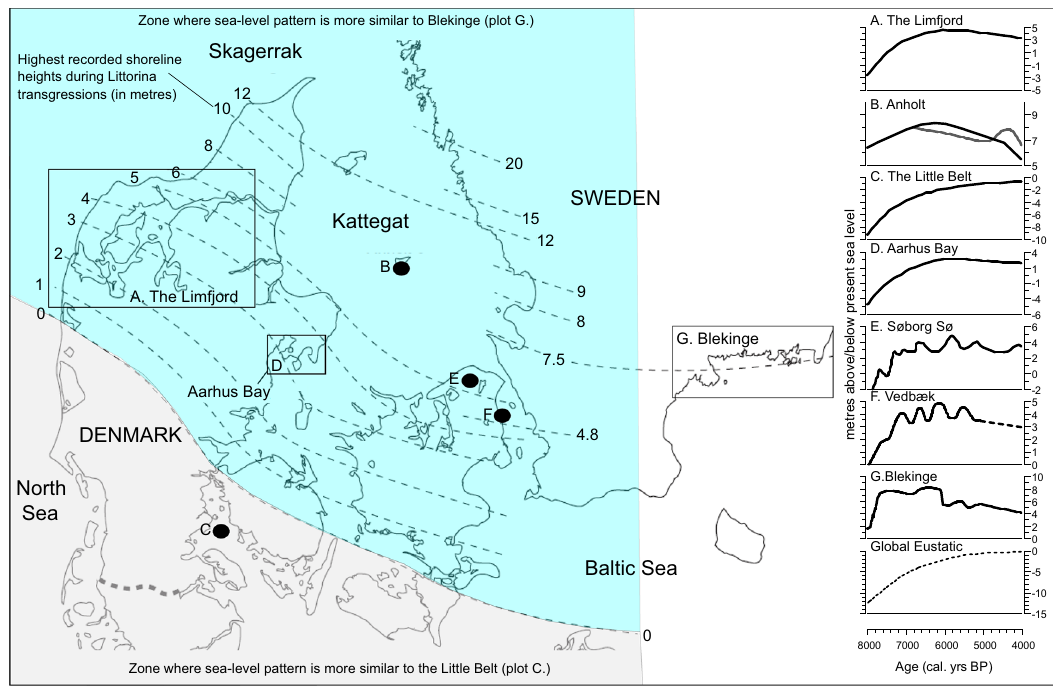
Fig. 1 Sea-level history of Southern Scandinavia. Map showing highest shoreline height during Littorina transgressions 8 , various sea-level curves 7,9,20,23 – 27 from Southern Scandinavia over the study period (8000 – 4000 cal. yr BP) and global eustatic sea-level change 28 . Note the variability in sea-level curves in terms of transgressive and regressive phases and sea-level